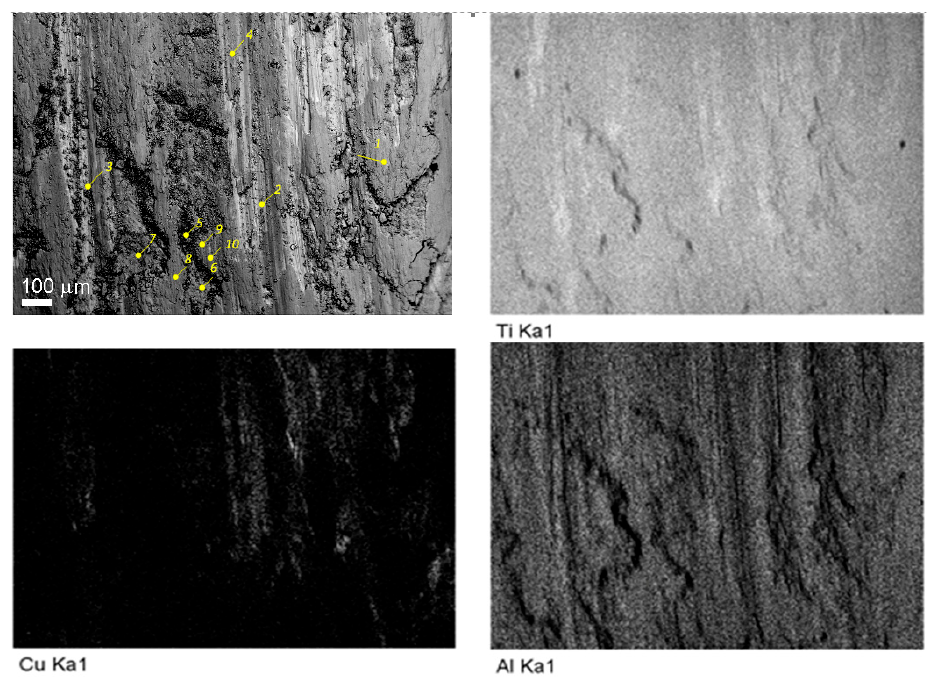
Figure 19. Worn surface of the 6-pass FSPed Ti6Al4V/Cu and EDS maps of basic alloy elements.